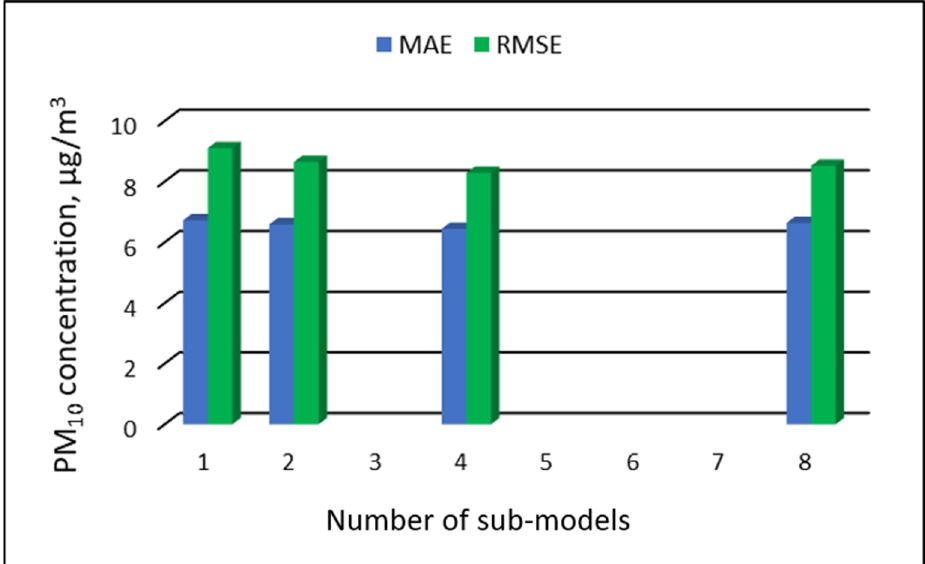
Figure 22. Overall MAE and RMSE values for PM 10 concentration prediction in PVS models depend- ing on the number of created sub-models, Z ł oty Potok.